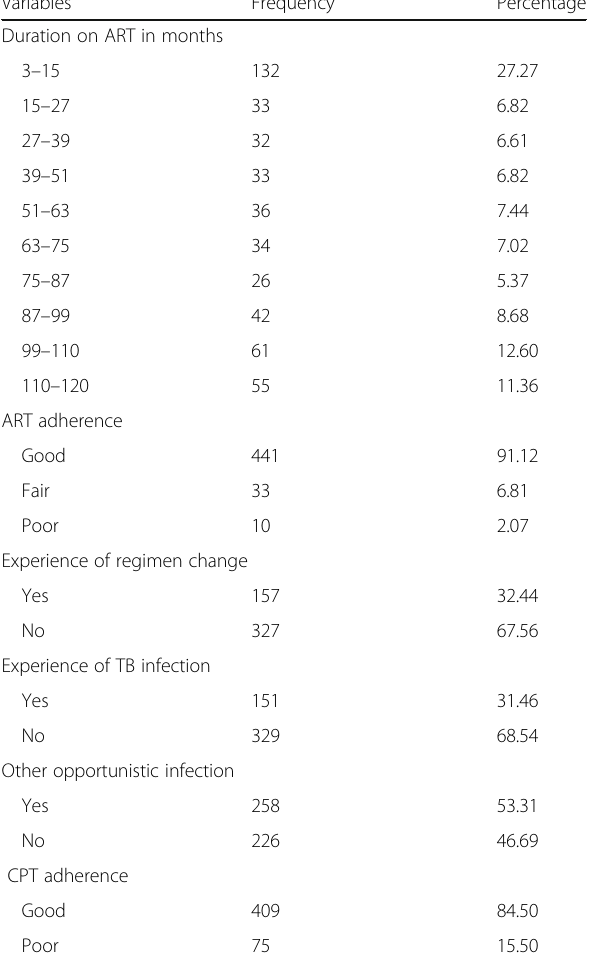
Table 3 Follow-up data of HIV-positive adults on ART at Debre Markos Referral Hospital who were followed from January 30, 2008, to January 26, 2018